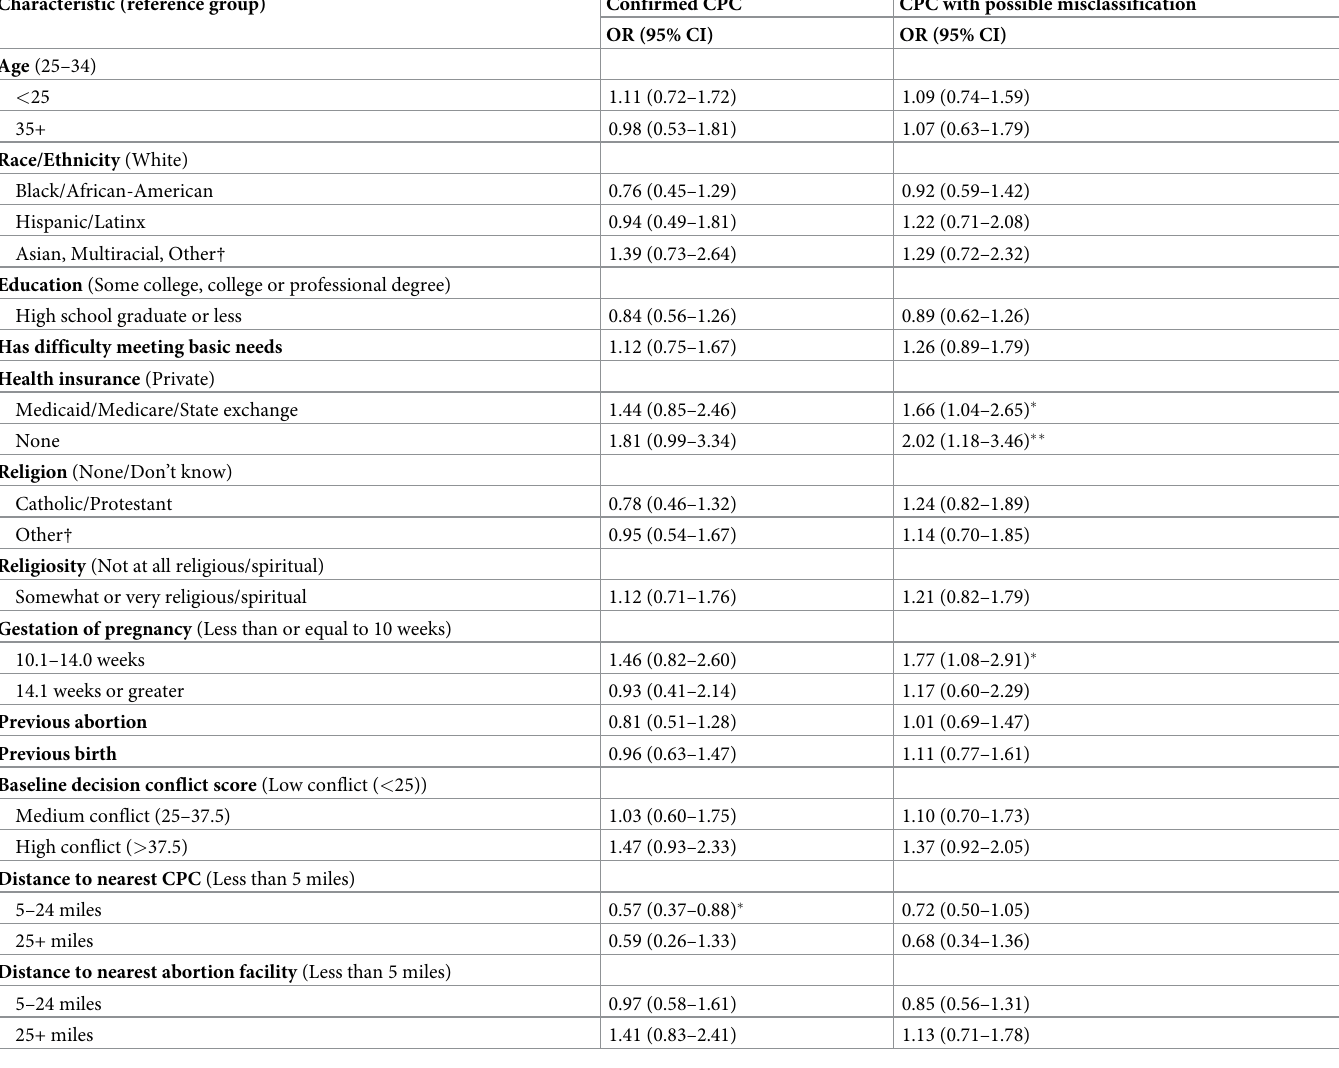
Table 2. Bivariate odds ratios for factors associated with exposure to a confirmed crisis pregnancy center (CPC) and exposure to a CPC with possible misclassifica- tion (N = 857). Characteristic (reference